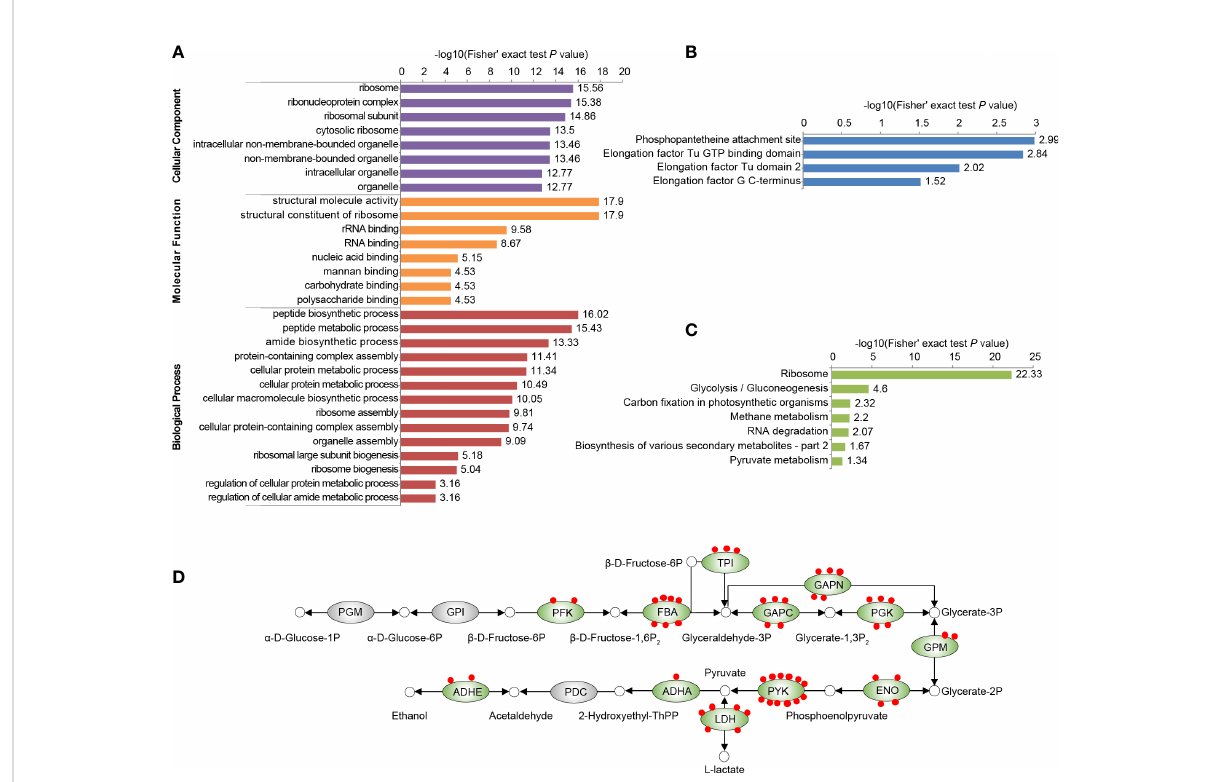
FIGURE 2 Functional enrichment analysis of all identi fi ed Kmal substrates in our proteomic study. (A) GO-based enrichment analysis of malonylated proteins. (B) Pfam-based enrichment analysis of domains related to malonylated proteins. (C) KEGG pathway-based enrichment analysis of malonylated proteins. For each category, a two-tailed Fisher ’ s exact test was employed to test the enrichment of the identi fi ed modi fi ed proteins against all proteins in the species database. Fold enrichment > 1.5 and adjusted P values < 0.05 were considered signi fi cant. (D) Malonylated enzymes involved in glycolysis in S. mutans . Green ovals indicate proteins subjected to malonylation, red dots represent Kmal sites. PGM, Phosphoglycerate mutase; GPI, glucose-6-phosphate isomerase; PFK, ATP-dependent 6-phosphofructokinase; FBA, fructose-1,6- biphosphate aldolase; TPI, triosephosphate isomerase; GAPC, glyceraldehyde-3-phosphate dehydrogenase; GAPN,